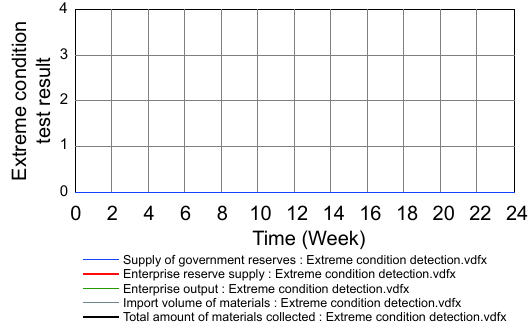
Fig. 5 Extreme condition test result chart of the peacetime and wartime material control model.